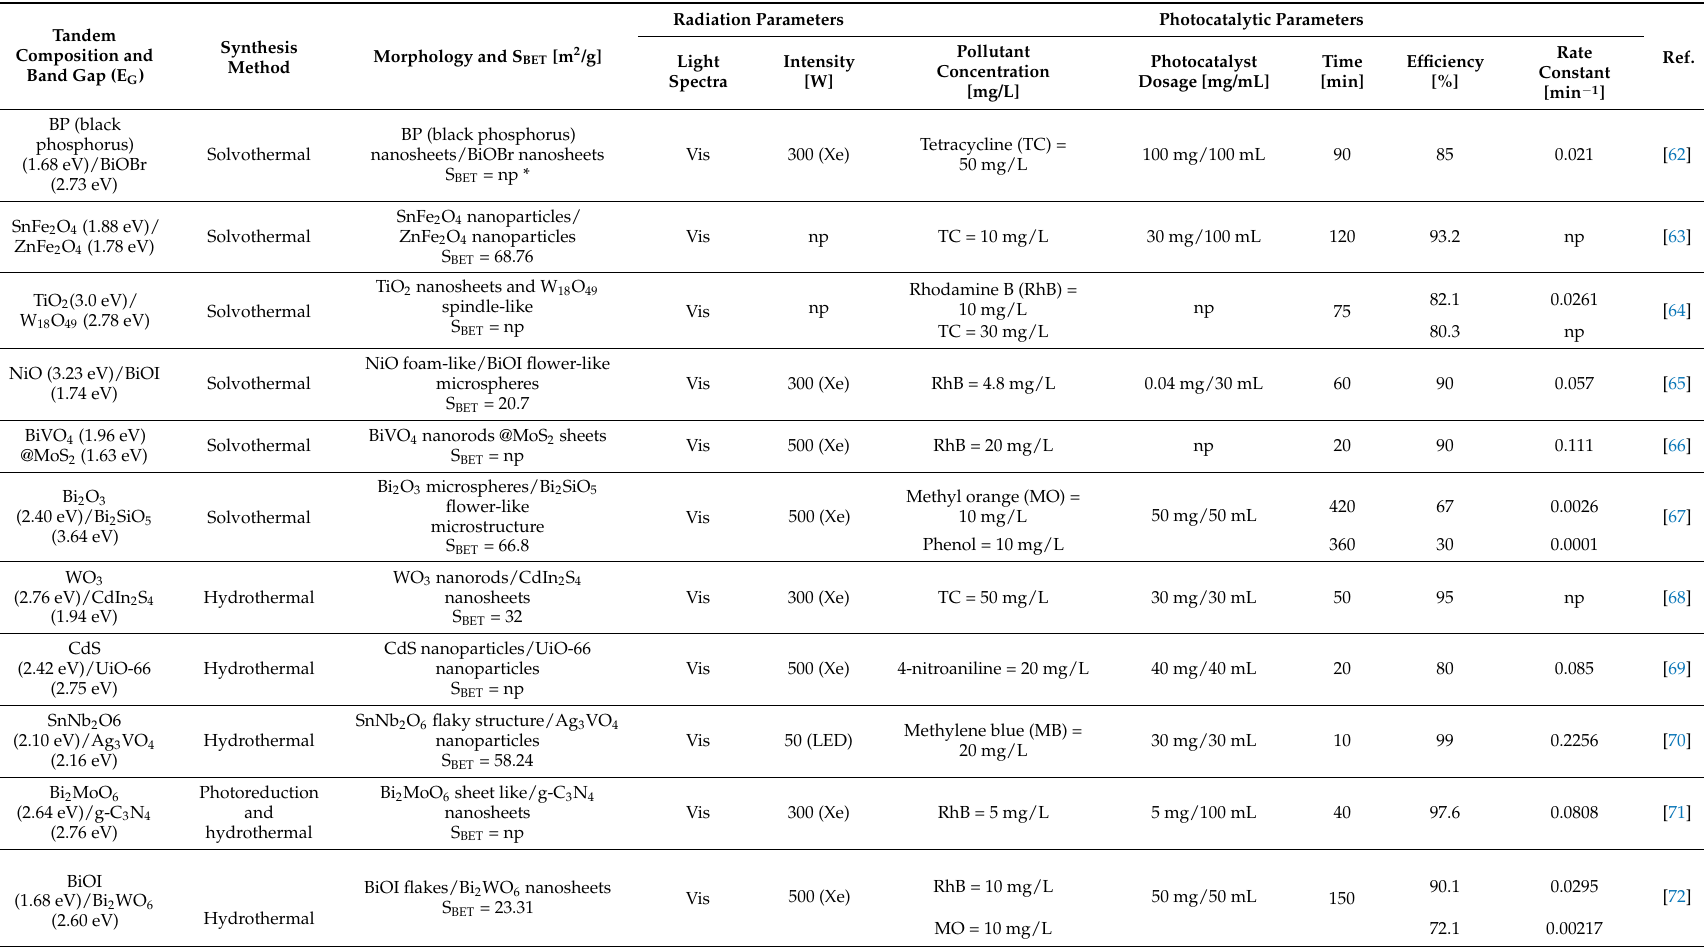
Table 1. Recent representative studies on the use of S-scheme heterojunction for organic pollutant